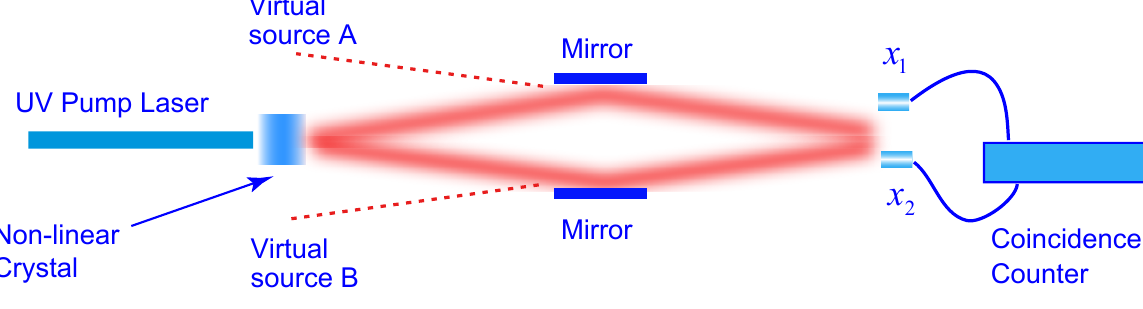
Figure 2: A schematic diagram of the Ghosh–Mandel experiment [36]. A UV pump laser falls on a non-linear crystal and produces pairs of entangled photons via spontaneous parametric down-conversion (SPDC), traveling in di ff erent directions. These photons are deflected by two mirrors and recombined where two movable detectors detect them in